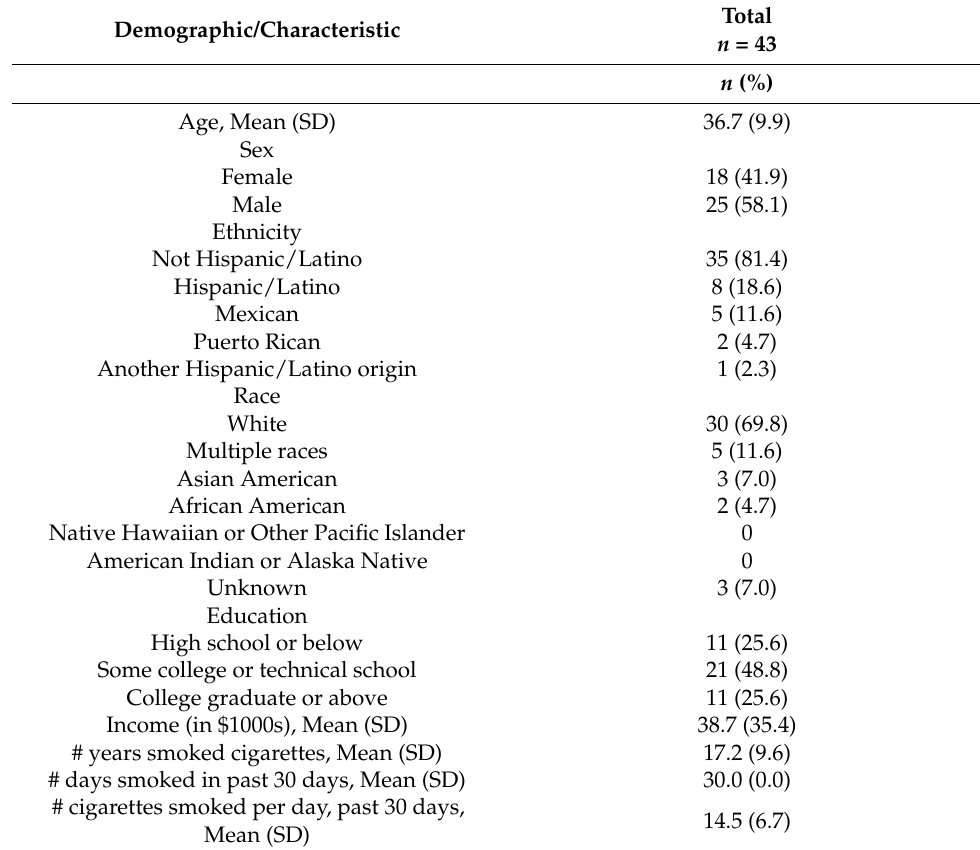
Figure 1. Randomized Cross-Over Clinical Trial of Unfiltered Cigarettes Study Design. Table 1. Study Participant Demographics and Baseline Characteristics.